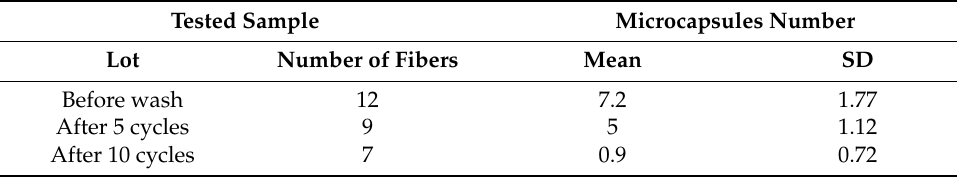
Figure 9. Optical photographs of treated fabric after washing cycles. Table 1. Microcapsules number before and after washing